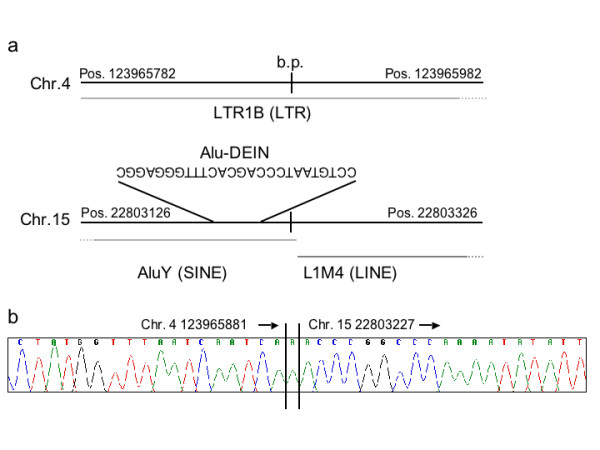
Repeat sequences surrounding the breakpoint . a . One hundred nucleotides on either side of the breakpoints on chromosome 4 and 15 contain repetitive sequences (grey lines). The Alu-DEIN sequence is located 13–39 bp upstream of the breakpoint on chromosome 15. b . Sequence across the breakpoint on the der(4) chromosome reveals an additional A inserted at the breakpoint. Arrows indicate the direction centromere to telomere.